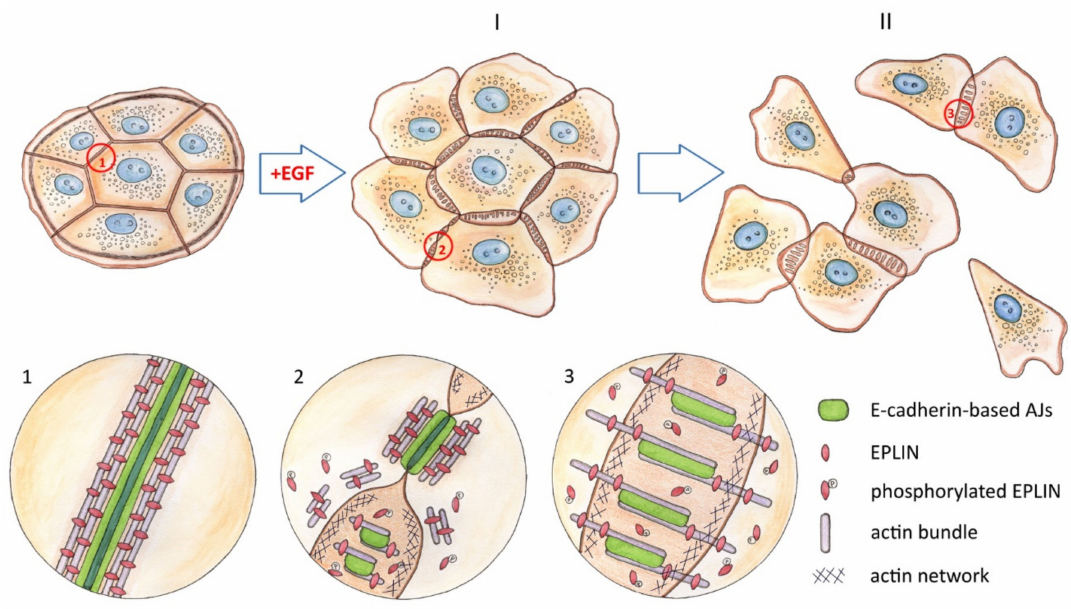
Figure 9. Schematic representation of the actin cytoskeleton reorganization and rearrangement of E-cadherin-based AJs during EGF-induced EMT (created by I.Y.